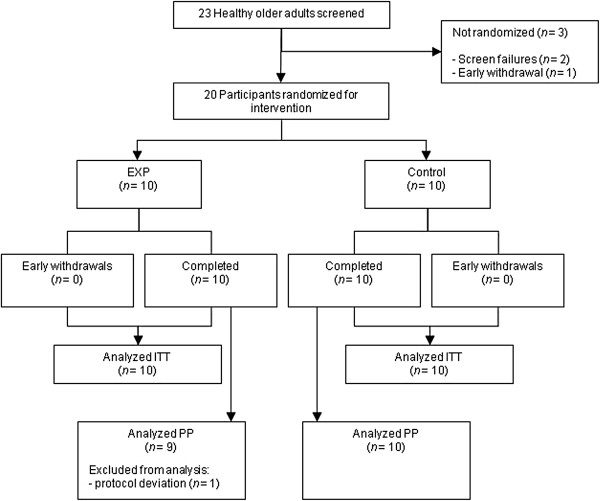
Flow diagram. Flow diagram of participants.